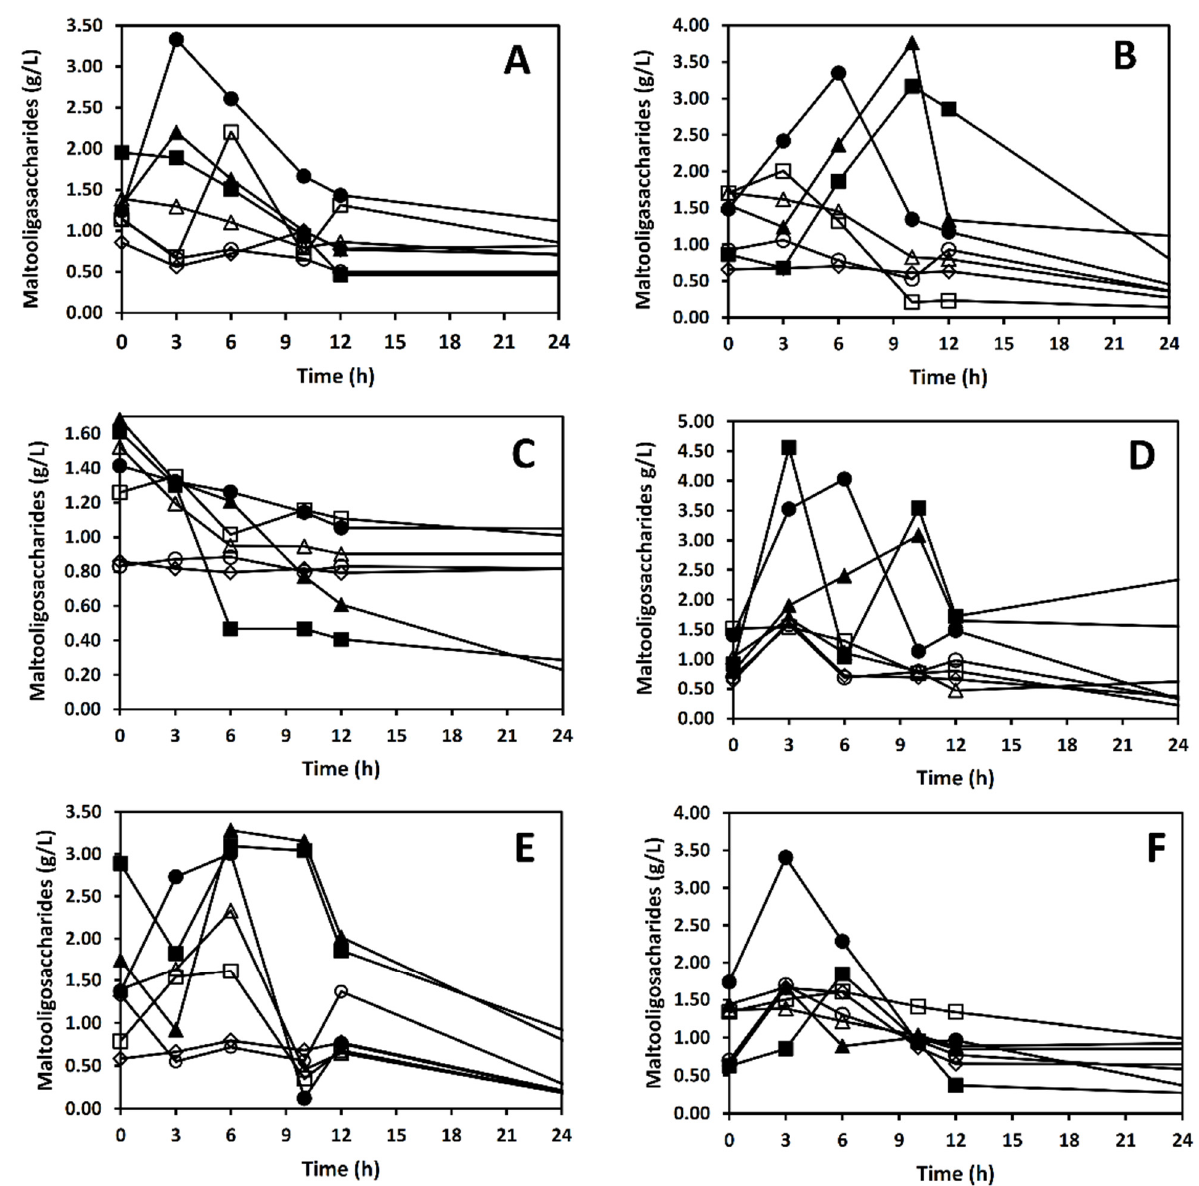
Figure 4. Hydrolysis products from starch fermentation using ( A ) Sii -25124; ( B ) L. plantarum A6 (new name Lactiplantibacillus plantarum ); ( C ) W. confusa 17; ( D ) L. plantarum A6- Sii -25124; ( E ) L. plantarum A6- W. confusa 17; ( F ) Sii -25124- W. confusa 17. Glucose ( ▲ ), maltose ( ■ ), maltotriose ( ● ), maltotetraose ( △ ), maltopentaose ( □ ), maltohexaose ( ○ ), maltohep- taose ( ◊ ).